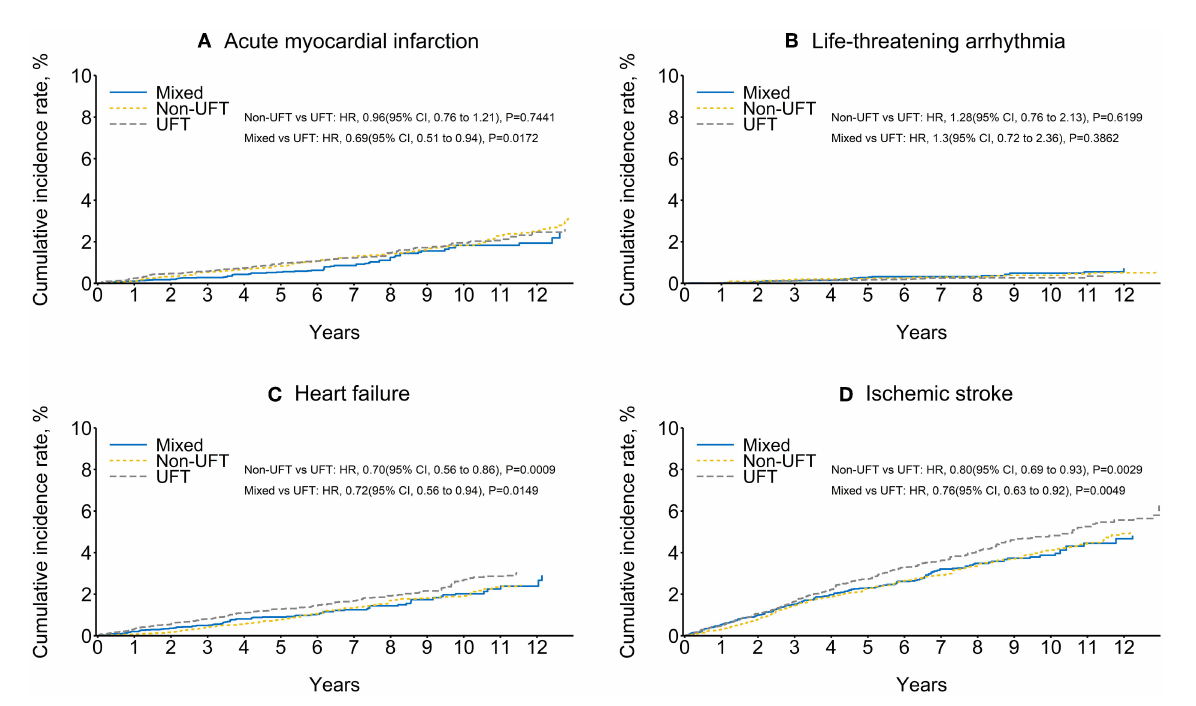
FIGURE4 Cumulative rate of cardiovascular outcomes among patients with stage II–III colorectal cancer after SIPTW (SIPTW, stabilized inverse probability of treatment weighting using propensity score; UFT,